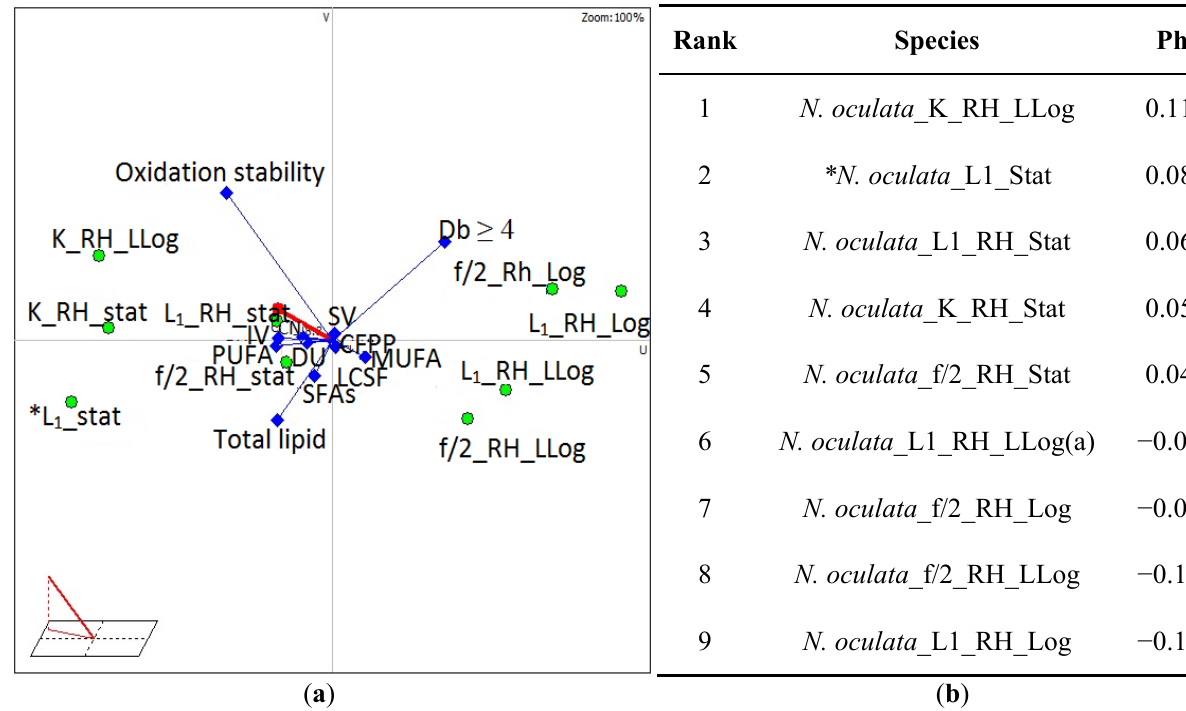
Figure 3. ( a ) GAIA plot of the effect of nutrients (media L1, f/2, K) and growth